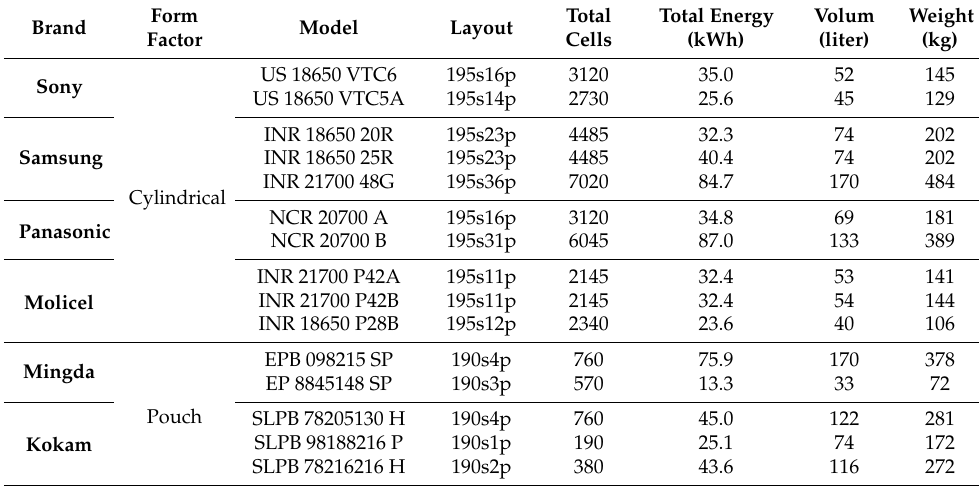
Table 4. Cells comparison, for 800 V and 500 A battery pack.